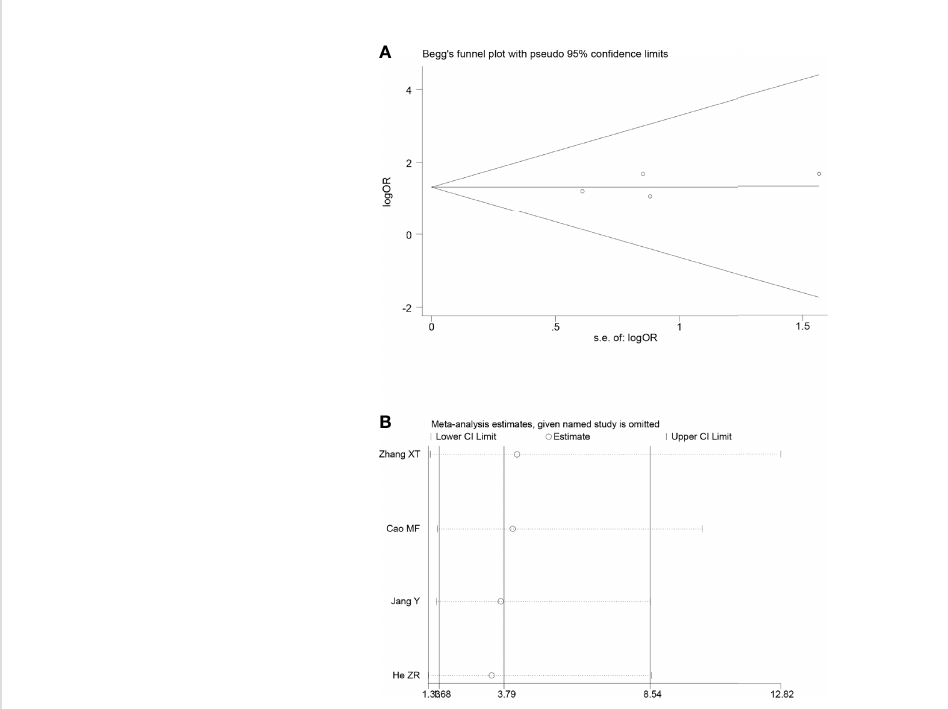
FIGURE 7 Begg ’ s funnel plot (A) and sensitivity analysis (B) of all the included studies for the analysis of CR.